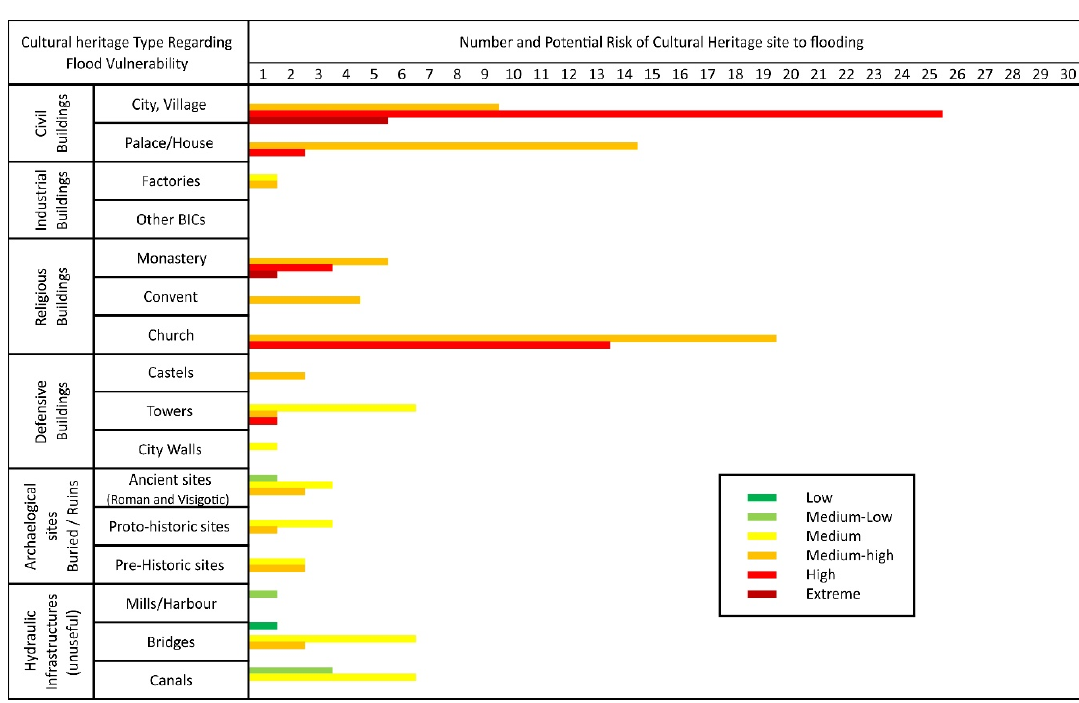
Figure 7. Distribution of flood potential risk levels for the different cultural heritage types defined for Castile and León region.